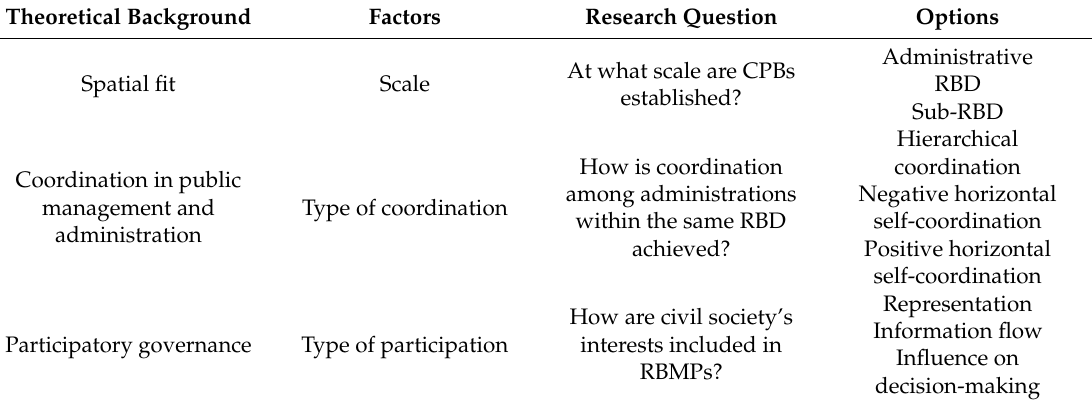
Table 1. Conceptual framework used to analyse the